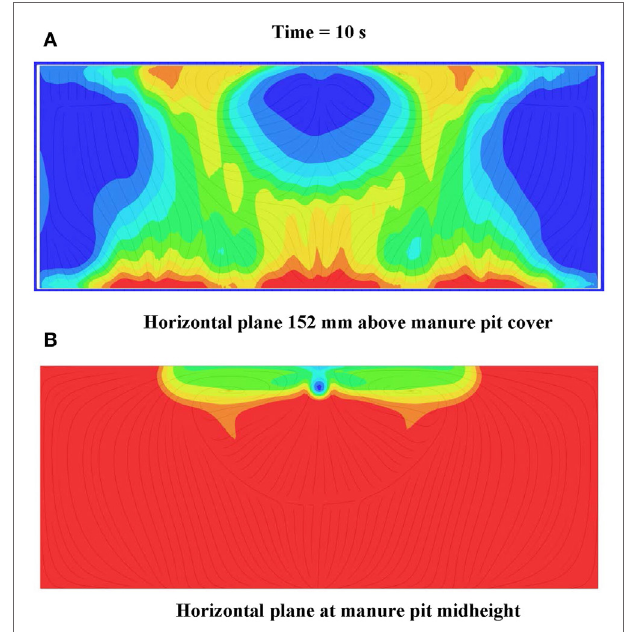
FIgURe 14 | Frames of (A) horizontal plane 152 mm above manure pit cover, and (B) horizontal plane at manure pit mid-height cut plot animations of hydrogen sulfide concentration 10 s after commencement of pit ventilation for case Study 2: cross-ventilated barn above slotted-covered manure pit (see Figure 11 for color legend for hydrogen sulfide)